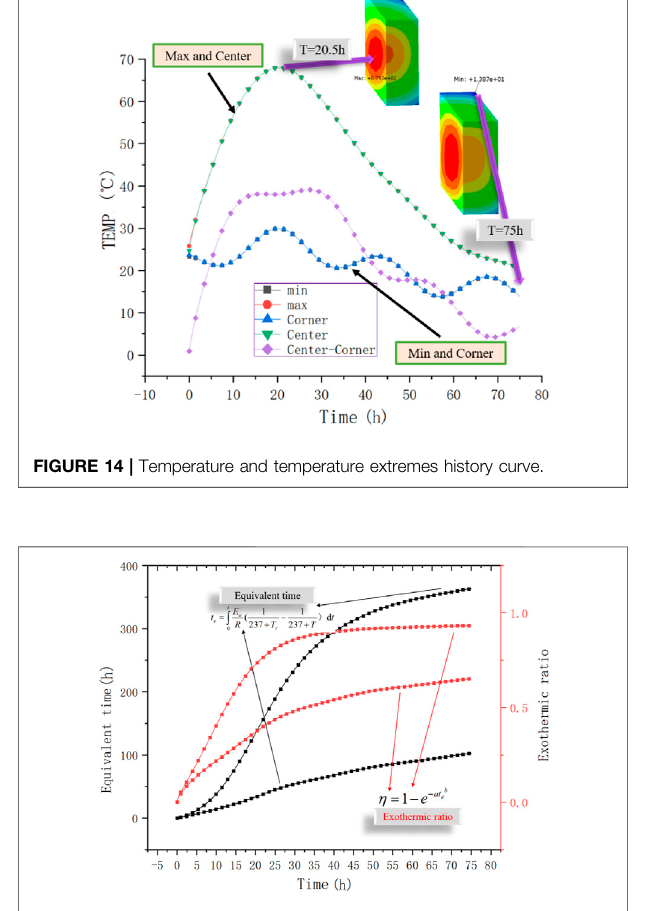
FIGURE 15 | Age and exothermic ratio history curve.